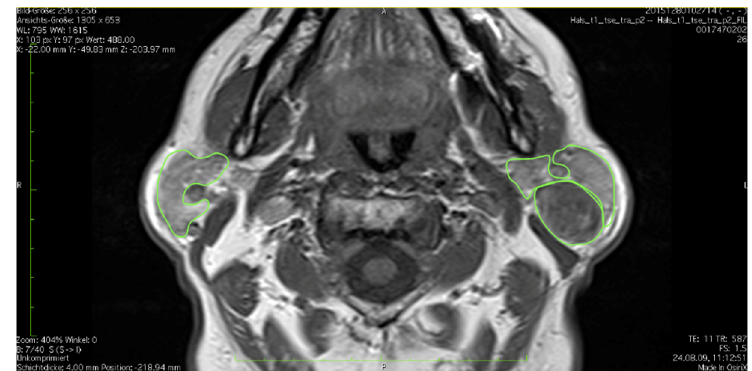
Figure 2. Example of the outlining of a lesion within the left parotid gland.